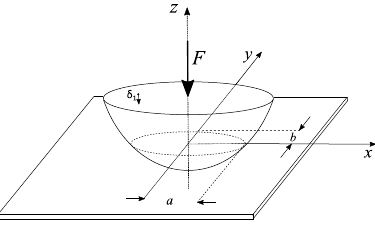
Figure 1. Schematic representation of the the system